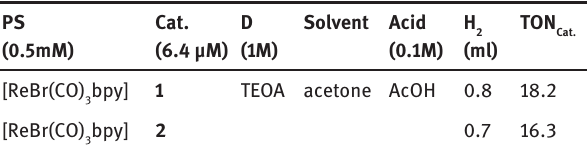
Figure 8: Hydrogen evolution with 0.25mM [ReBr(CO) AcOH / 1M TEOA in degassed acetone with different concentrations of the catalyst 2 : (16μΜ, 32μM, 64μM, 96μM), at room Table 2: Hydrogen evolution with different PS and Cat. after 24 h irradiation.